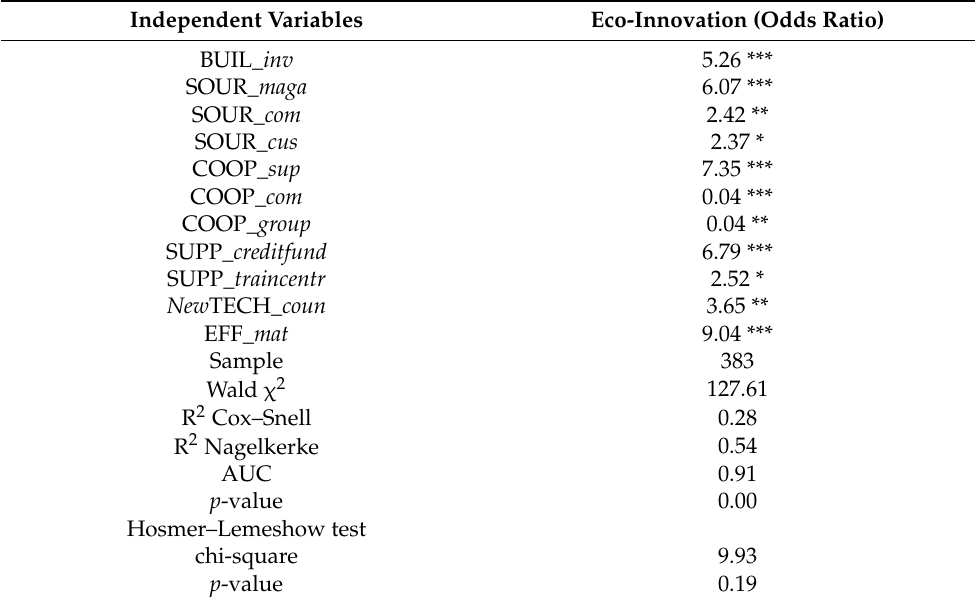
Table 3. Determinants for eco-innovation in the Polish ICT sector in 2018–2020, logit function. Independent Variables Eco-Innovation (Odds